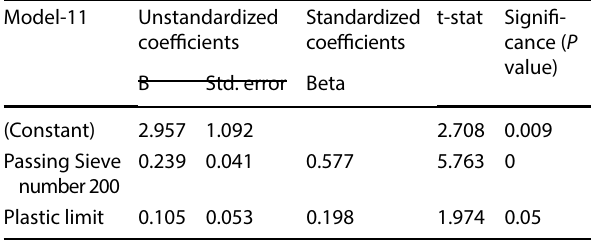
Table 10 The MLR model for predicting the OMC Model-11 Unstandardized coefficients